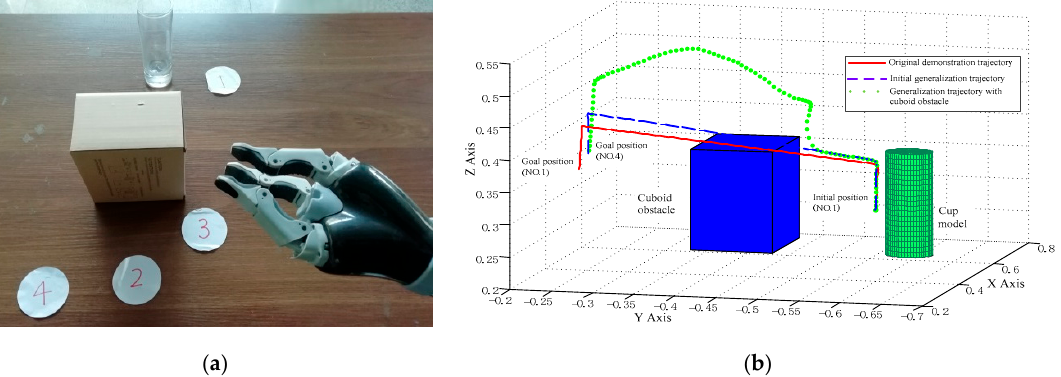
Figure 11. Experiment of placing a cup with a large cuboid obstacle: ( a ) initial experiment setting with cuboid obstacle; ( b ) generalization trajectory with a cuboid obstacle.